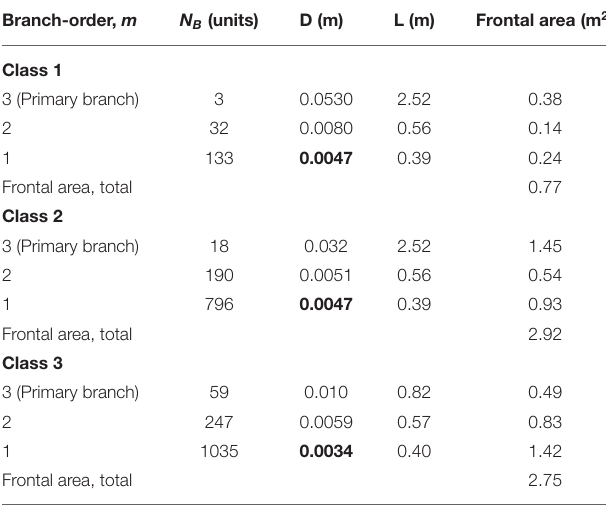
50 mm), ≤ 20 mm) of tree S ≤